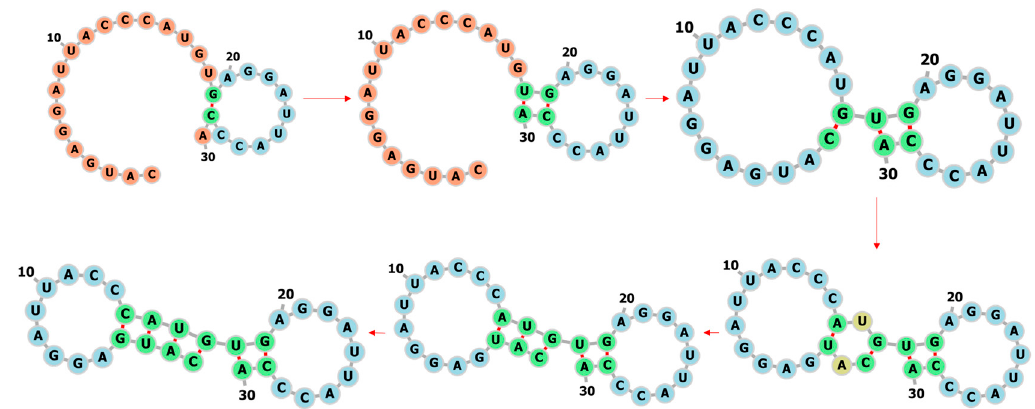
Figure 8. The fastest secondary structure folding path prediction results of PDB_00972.